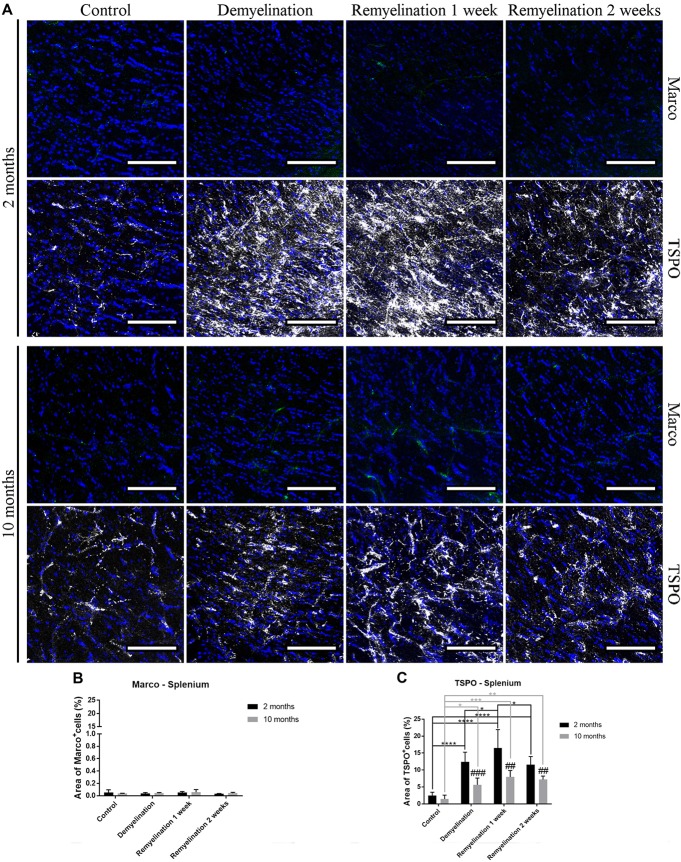
Age-related differences in cuprizone-induced increase of TSPO in the splenium of the CC, while Marco remains unaffected. (A) Marco (green) and TSPO (white) labeling. Cell nuclei are stained with DAPI (blue). (B) No significant effects of age or treatment on Marco levels were observed. (C) In both age groups, TSPO was significantly increased during de- and remyelination. TSPO levels were significantly higher in the younger de- and remyelination groups. Values are shown as means + SD (n = 6 per group). Statistical significance was evaluated using a two-way ANOVA followed by a Tukey’s post hoc test (C). The p-values are indicated in the graphs: treatment effects within the same age group: *p < 0.05, **p < 0.01, ***p < 0.001 and ****p < 0.0001, age-related differences: ##p < 0.01 and ###p < 0.001. Bars: (A) 100 μm.